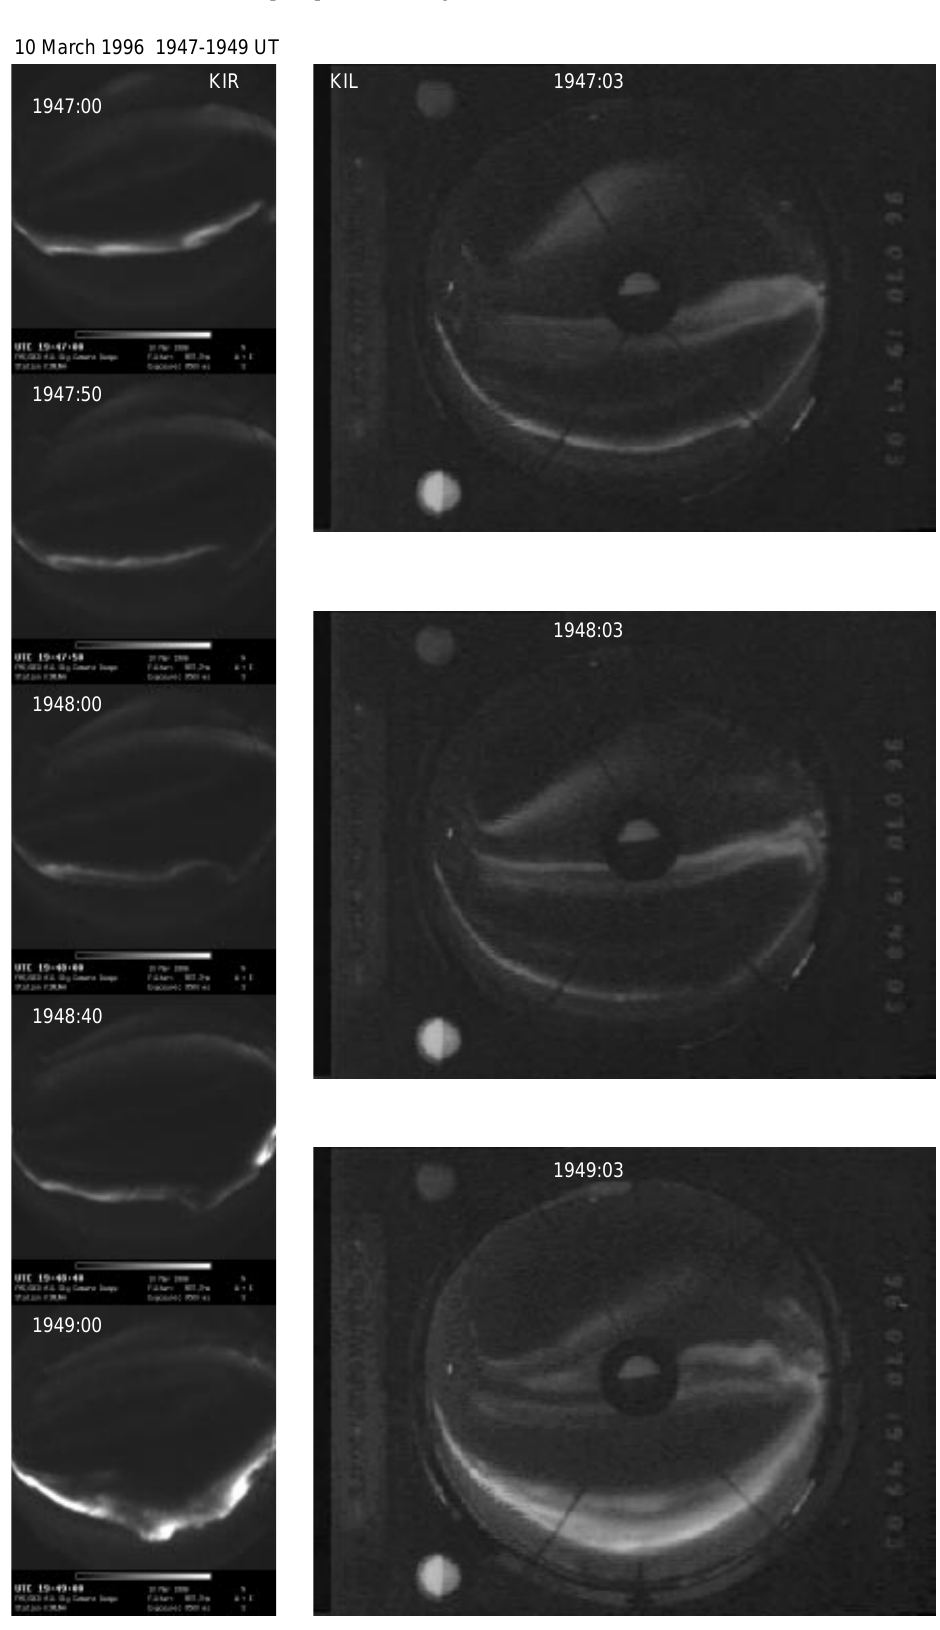
Fig. 10. Fading event on 10 March 1996: ASC recordings at ( left ) KIR and ( right ) KIL. The fading arc is the brightest one at KIR and the southernmost one at KIL. The fading is visible in the frames around 1948 UT as a local weakening in the auroral lumino- city in the eastern part of